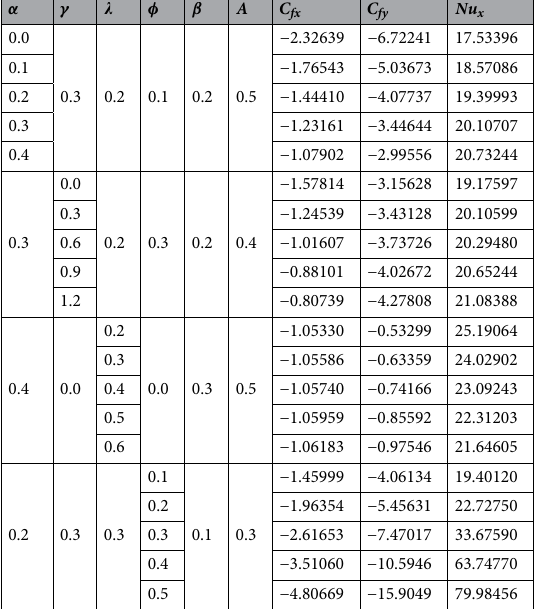
Table 3. Numerical values of Distinct Parameters on Skin Friction